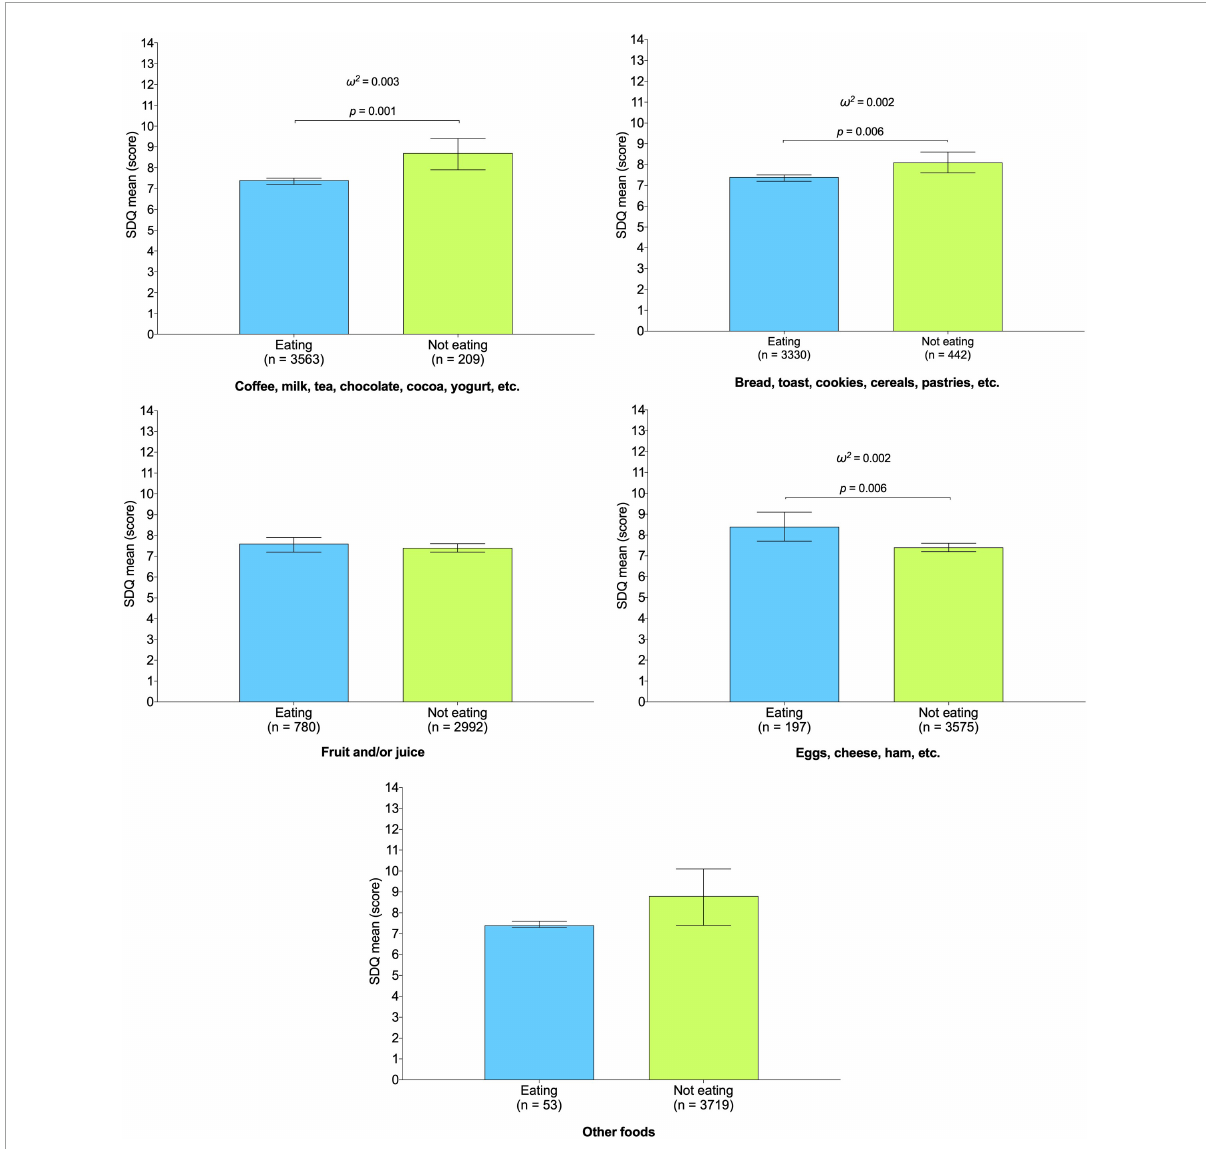
FIGURE2 Association between different breakfast habits and Strengths and Difficulties Questionnaire mean score in young population. Estimated mean (bars) and 95% CIs (lines) represent values after adjustment for age, sex, region, social class, immigrant status, excess weight, physical activity level, recreational screen time, sleep duration, and Spanish Healthy Eating Index score. Analyses were also adjusted for the remaining possible habits (i.e., the consumption of "coffee, milk, tea, chocolate, cocoa, yoghurt, etc." was further adjusted for "bread, toast, biscuits, pastries, etc.," "fruit and/or juice," "eggs, cheese, ham, etc.", and "other